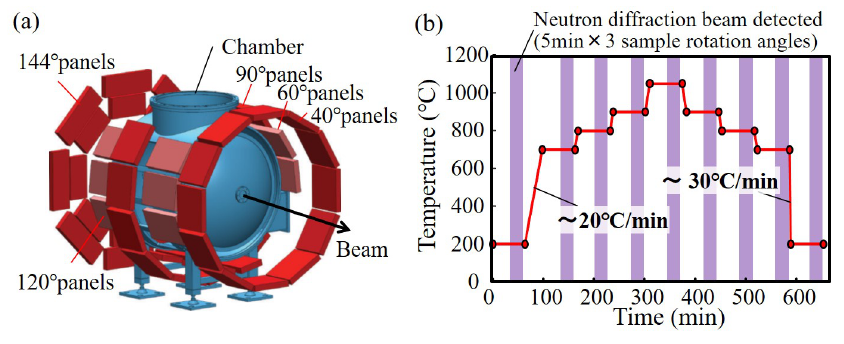
Figure 3. ( a ) The HIPPO diffractometer. ( b ) Heat pattern used in the present neutron diffraction